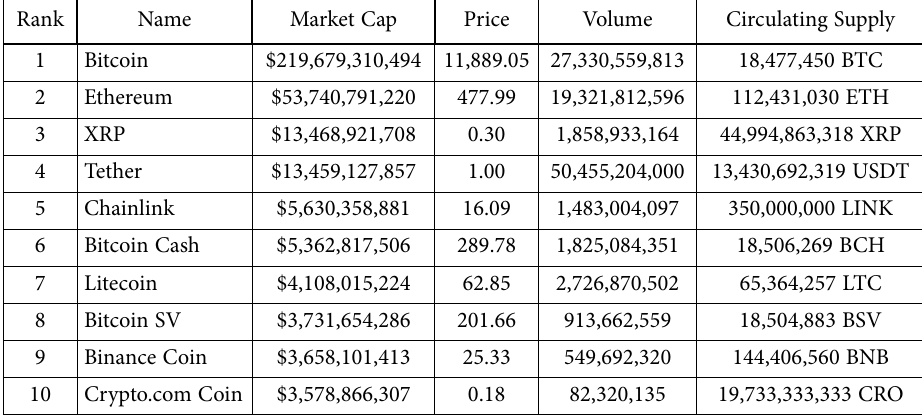
Table 1. The top 10 on market capitals of cryptocurrencies in 2020 (source: Coin Market Cap, 2020)